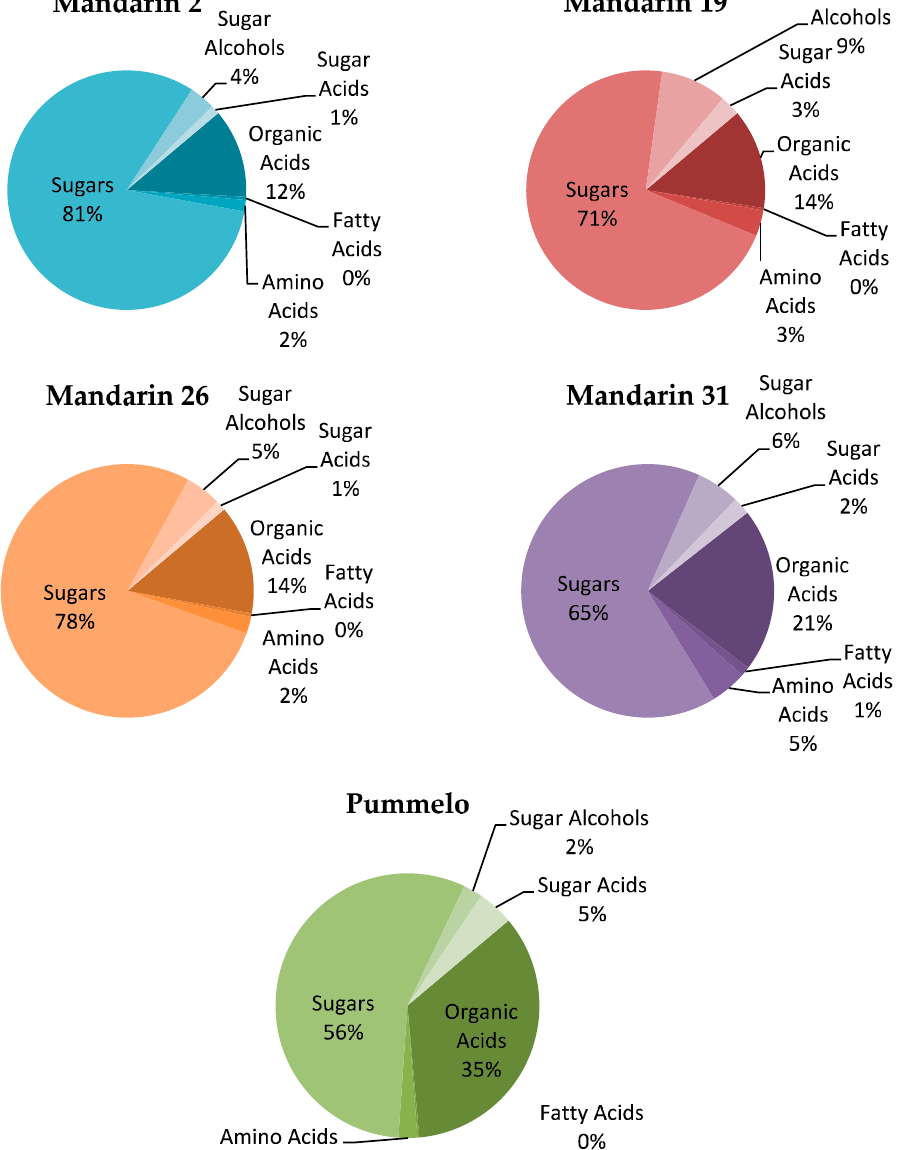
Figure 3. Percentage composition of metabolic groups found in four Cleopatra Mandarin selections and Pummelo.